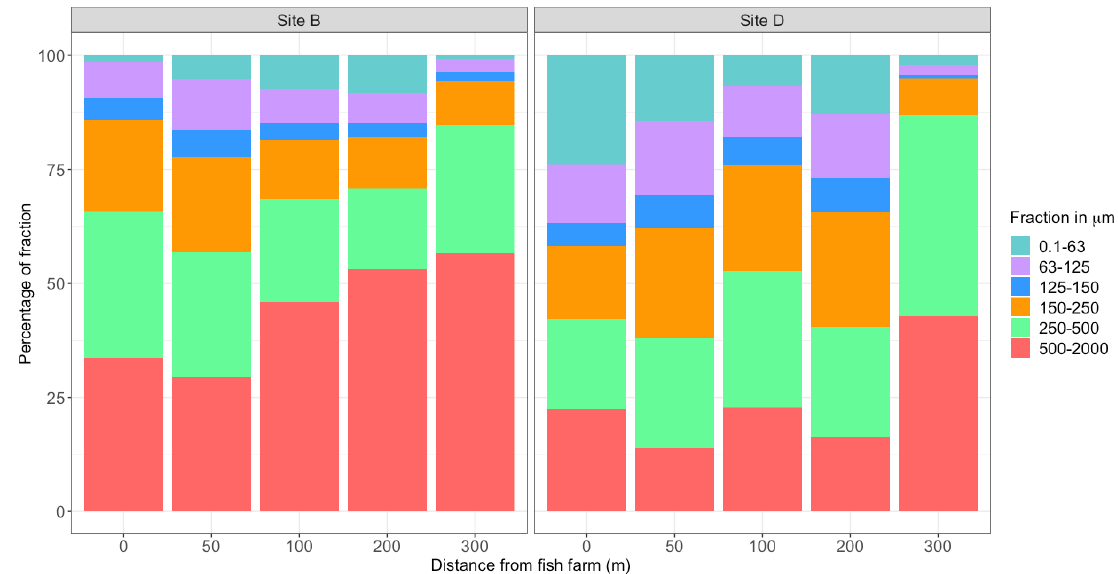
Figure 2. Distribution of sediment grain fractions for the different sites. Sites B (2.02 ± 1.04%) and D (1.71 ± 1.28%) show relatively similar total